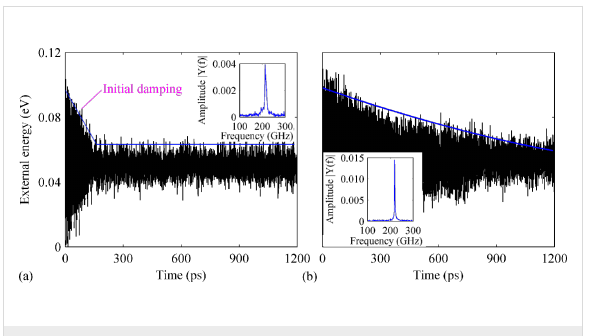
Figure 4: Variation of the external energy over time for a perfect GNR with B- and N-dopants. The total density of dopants is (a) 1.27% and (b) 1.65%. The insets show the corresponding frequency